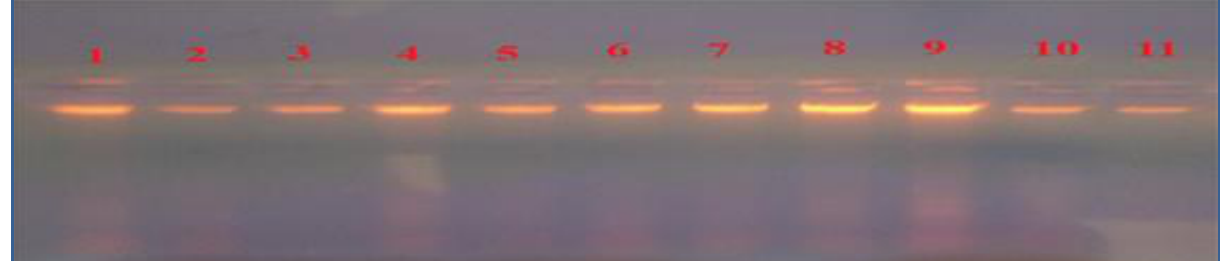
Figure, 3: Gel electrophoresis of 1.5% agarose gel stained with ethidium bromide for DNA extraction of Salmonella isolates.